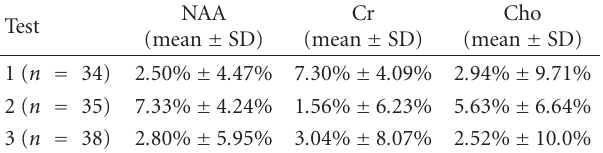
Table 1: Comparisons of signal amplitudes acquired on a phantom with or without spacing between slices. Means and SD were calculated using (2). n is the number of selected voxels in the 4th slice. The TR was 2.3s for tests 1 and 2, and 3.0 s for test 3. The labeled concentrations for NAA, Cr, and Cho were 12.5, 10.0, and 3.0mM, respectively.